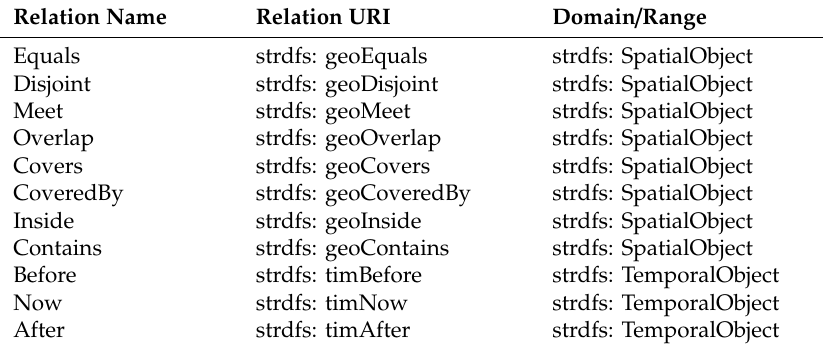
Table 1. Topological relations among spatiotemporal